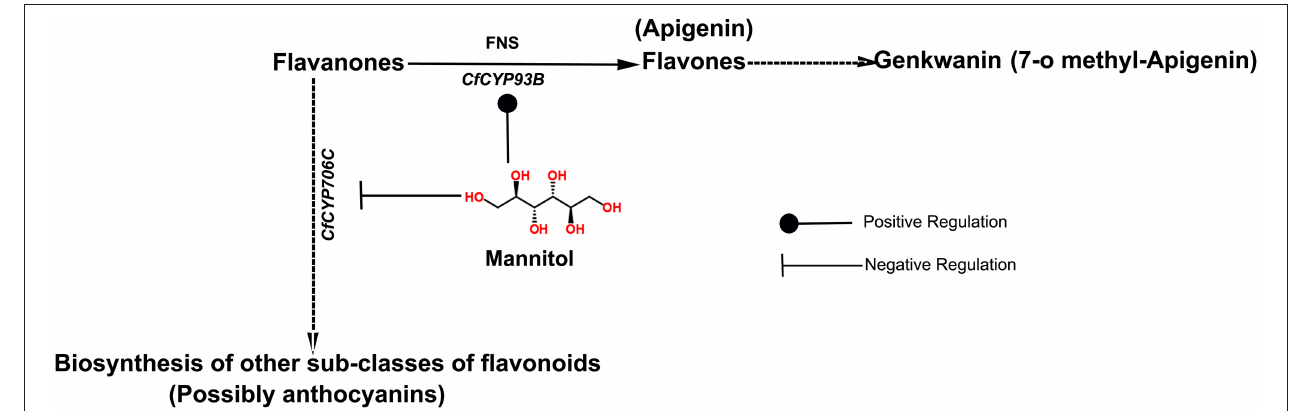
FIGURE 6 | Regulation of transcript expression of CfCYP93B and CfCYP706C in response to mannitol treatment. Positive and Negative Regulation of CfCYP93B and CfCYP706C in response to mannitol treatment,